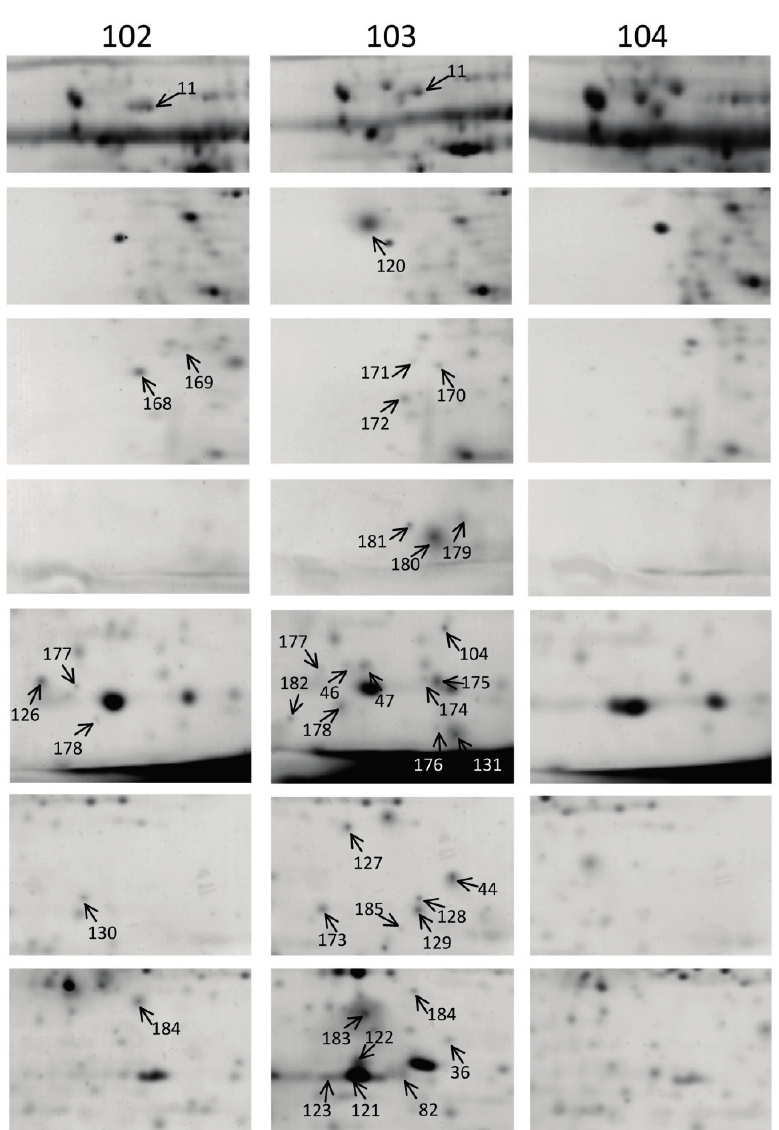
Figure 2. Protein spots specifically detected in isopentenyltransferase (ipt) -transgenic broccoli after cooking. Number indicates protein spots specifically detected in the 2 ipt -transgenic lines 102 or 103 after cooking as compared with the control